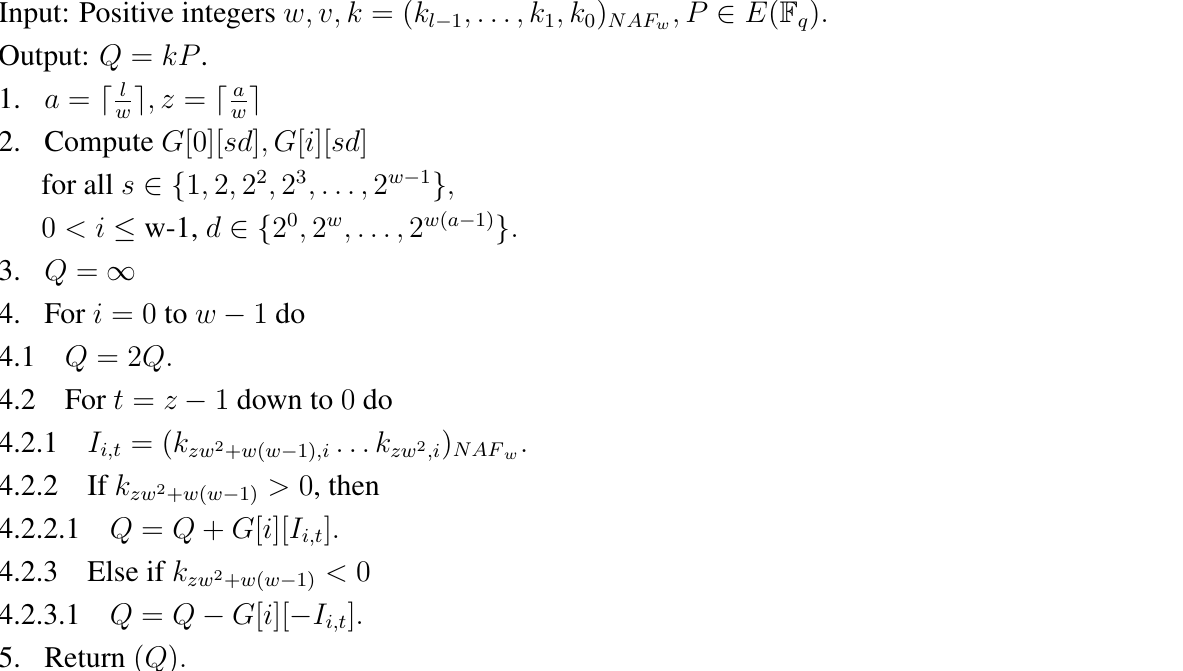
Algorithm 8. (Proposed) Fixed-base comb with Window-NAF method for scalar multiplication.